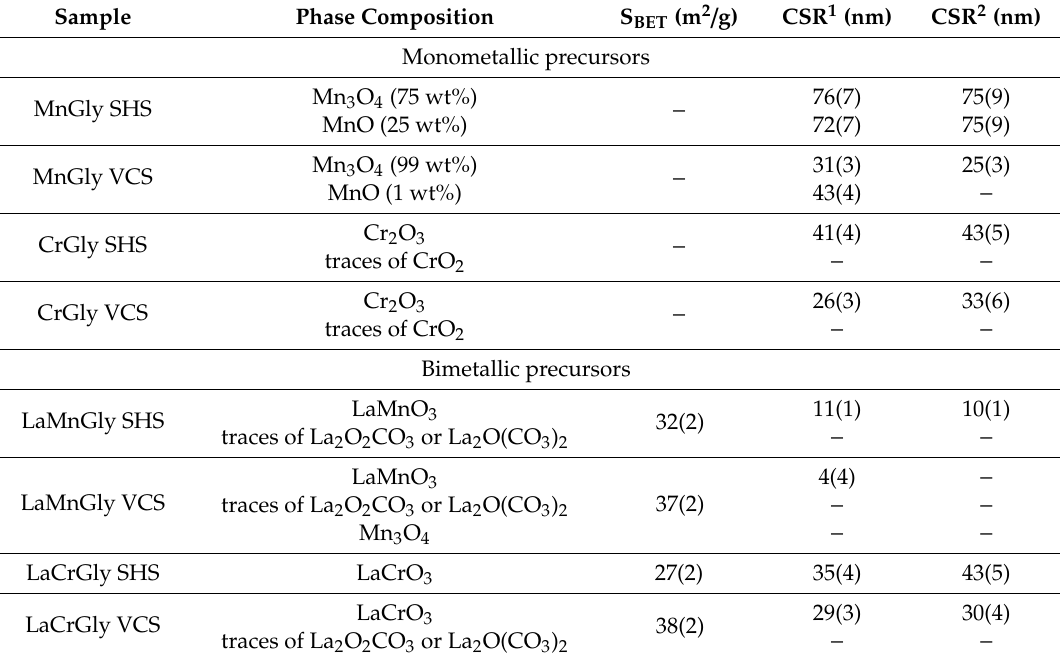
Table 2. Phase composition and specific surface area for combustion products formed in the di ff erent regimes. The standard deviation is indicated in